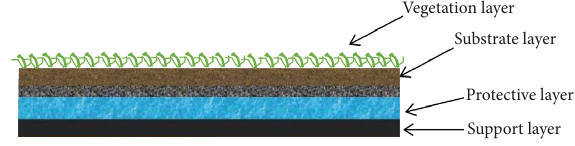
Figure 4: Scheme of the green roof